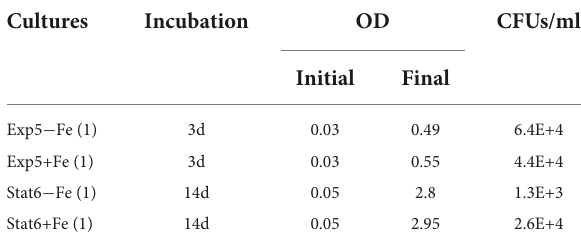
TABLE 1 Culture conditions and CFUs